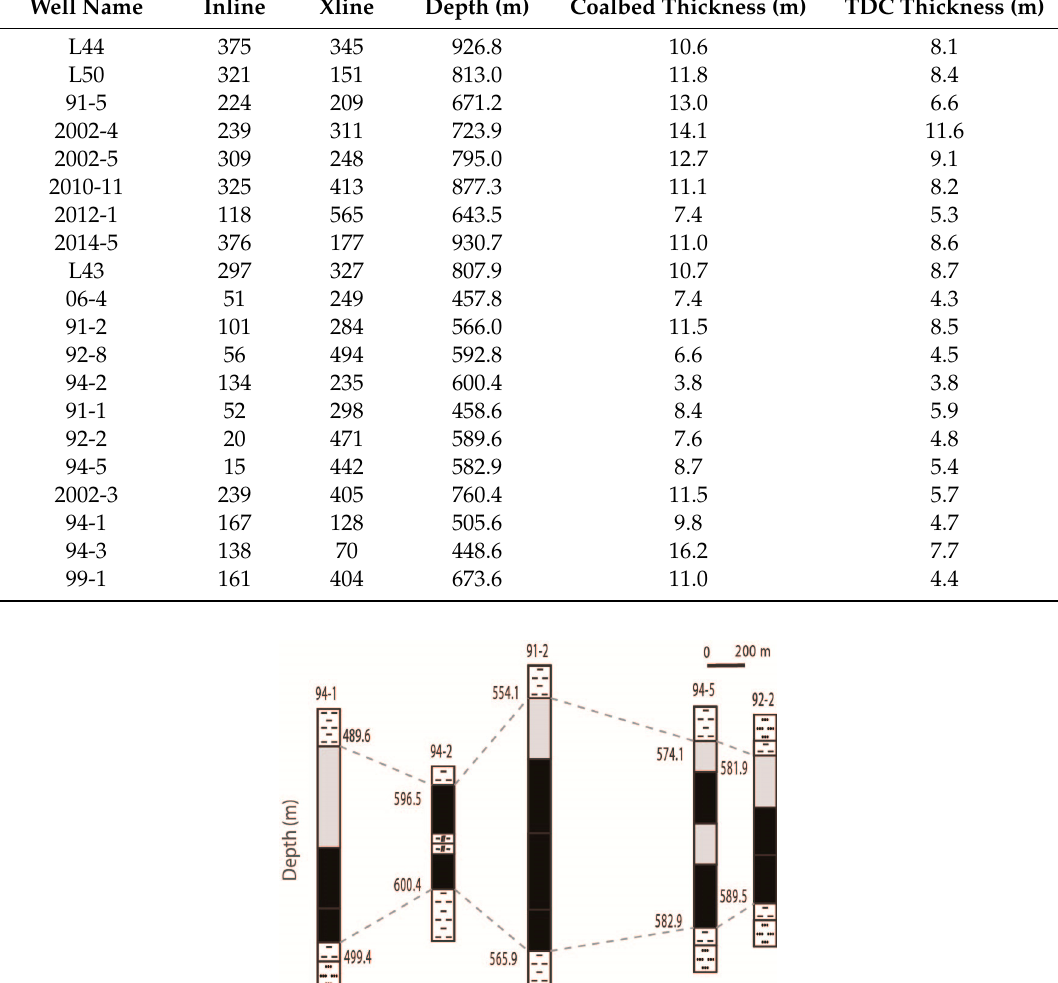
Table 3. Well-logging measured TDC thickness of No. 8 coal.